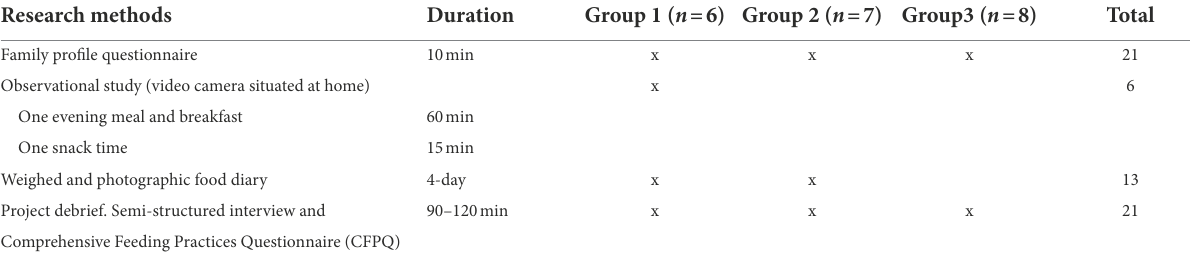
TABLE 1 Overview of research methods used, duration of each task and sample size. Research